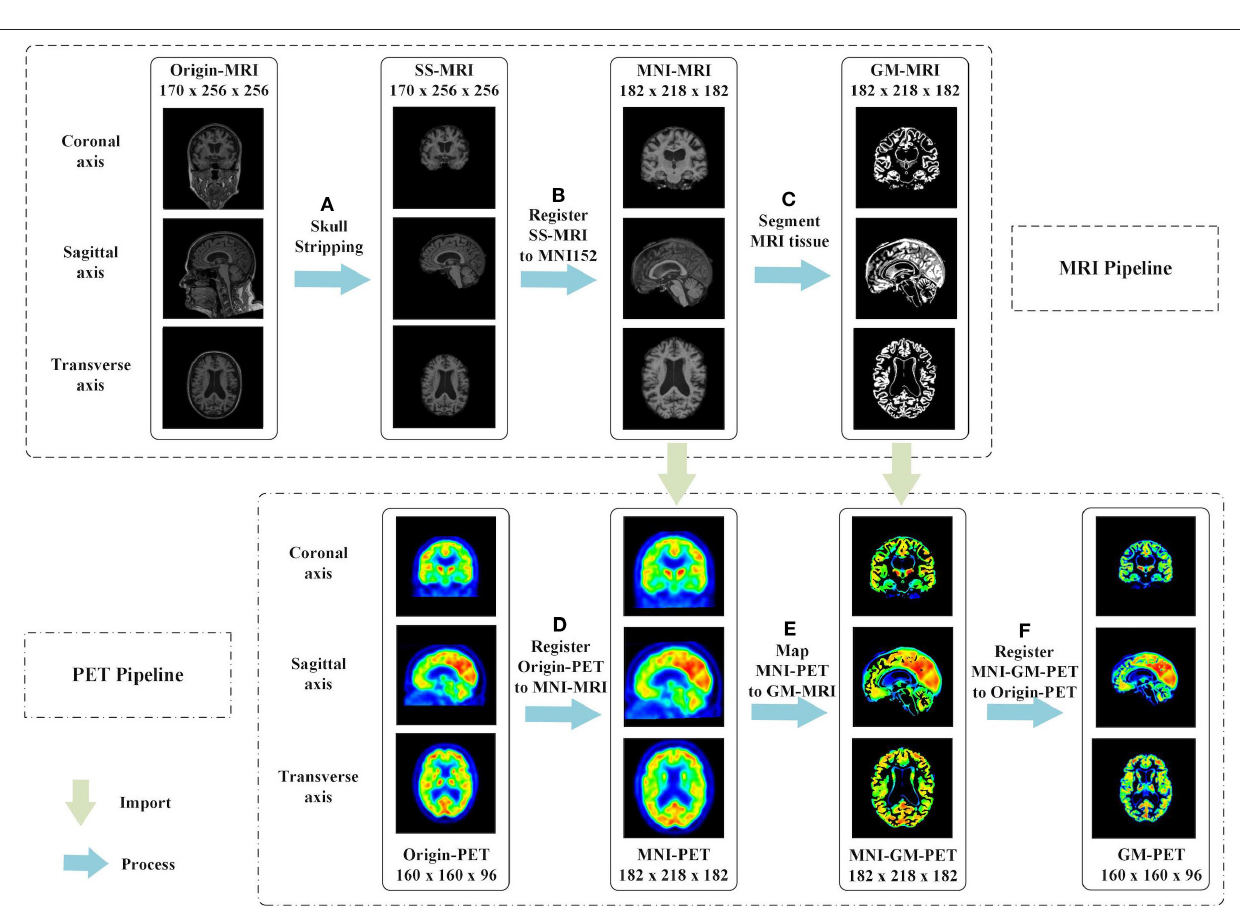
into different tissue types, while correcting for spatial intensity variations (also known as bias field or RF inhomogeneities). The underlying method is based on a hidden Markov random field model and an associated expectation-maximization